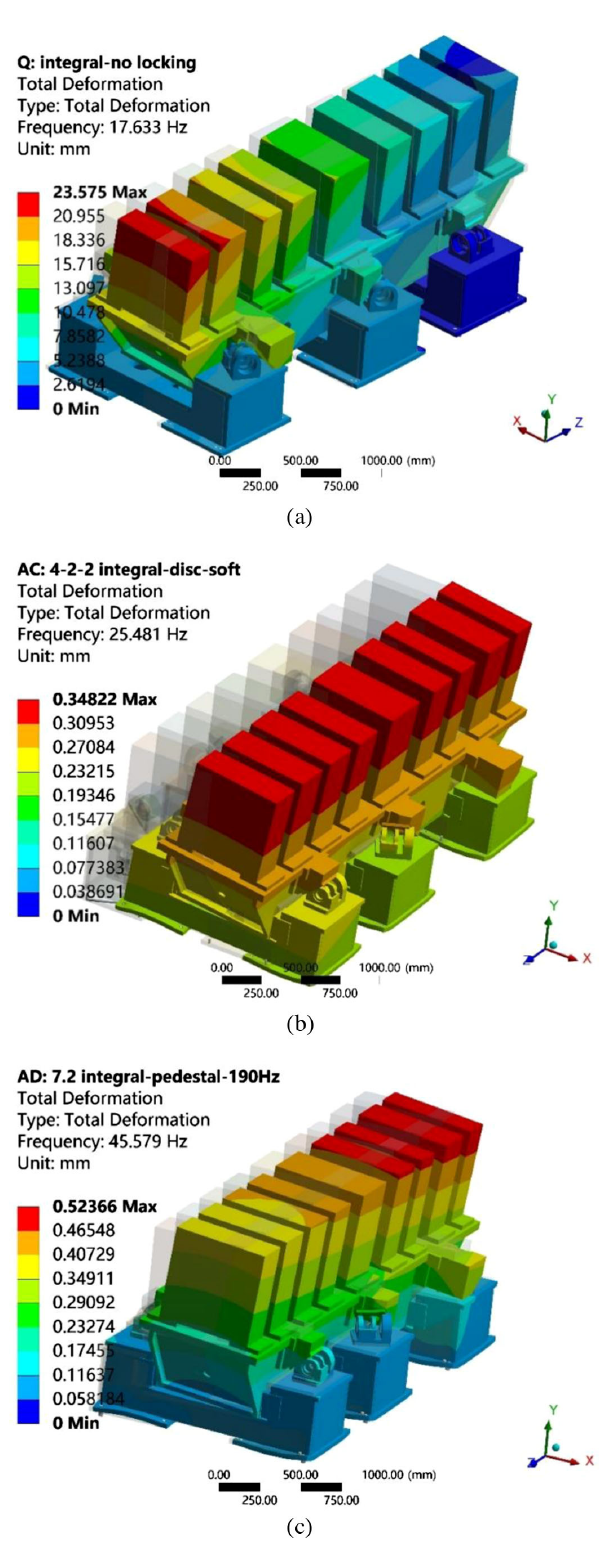
FIG. 7. Amplitude of harmonic response of the magnet on the side of the